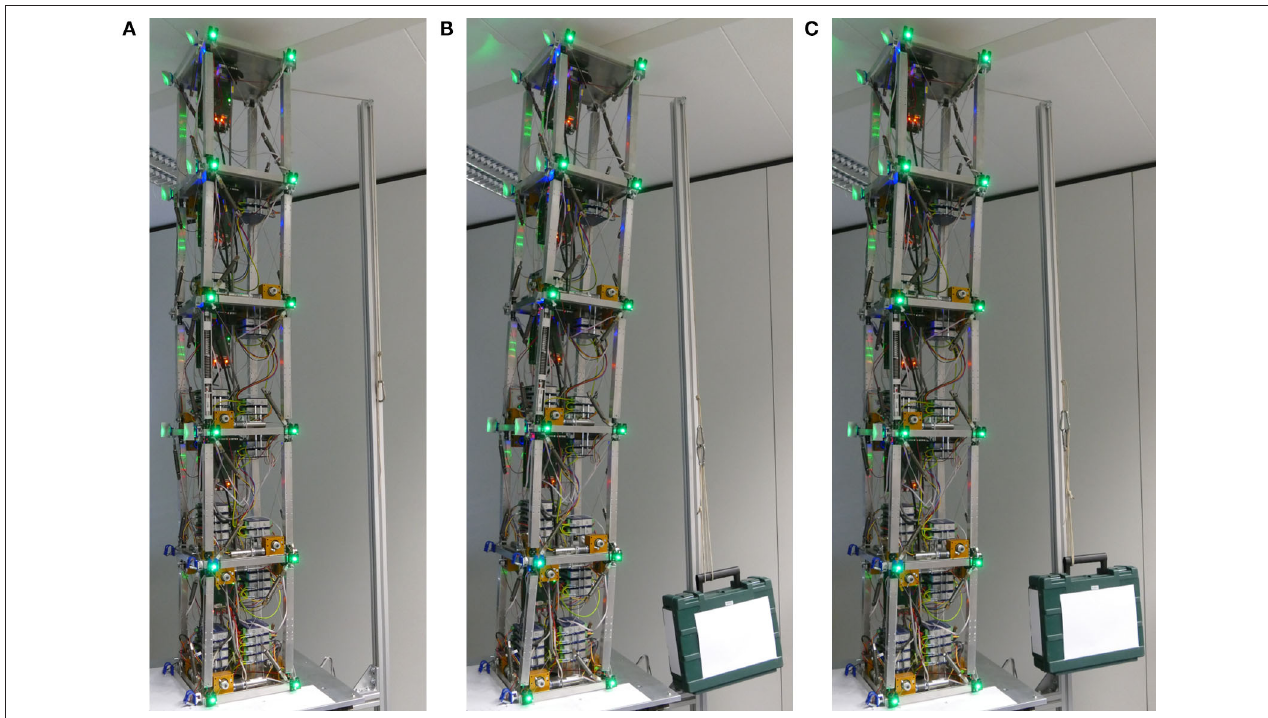
FIGURE 5 | Photographs of the experimental setup of the scale model. (A) Upright state as reference, (B) applied load without compensation, and (C) compensation of the displacement caused by the